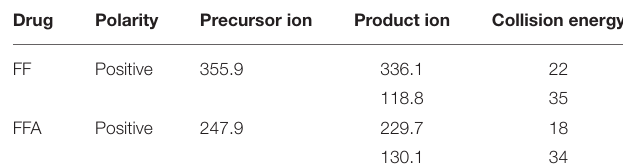
TABLE 2 | Optimized characteristic ion mass spectrometry parameters for TS and 6 β -OHTS. Drug